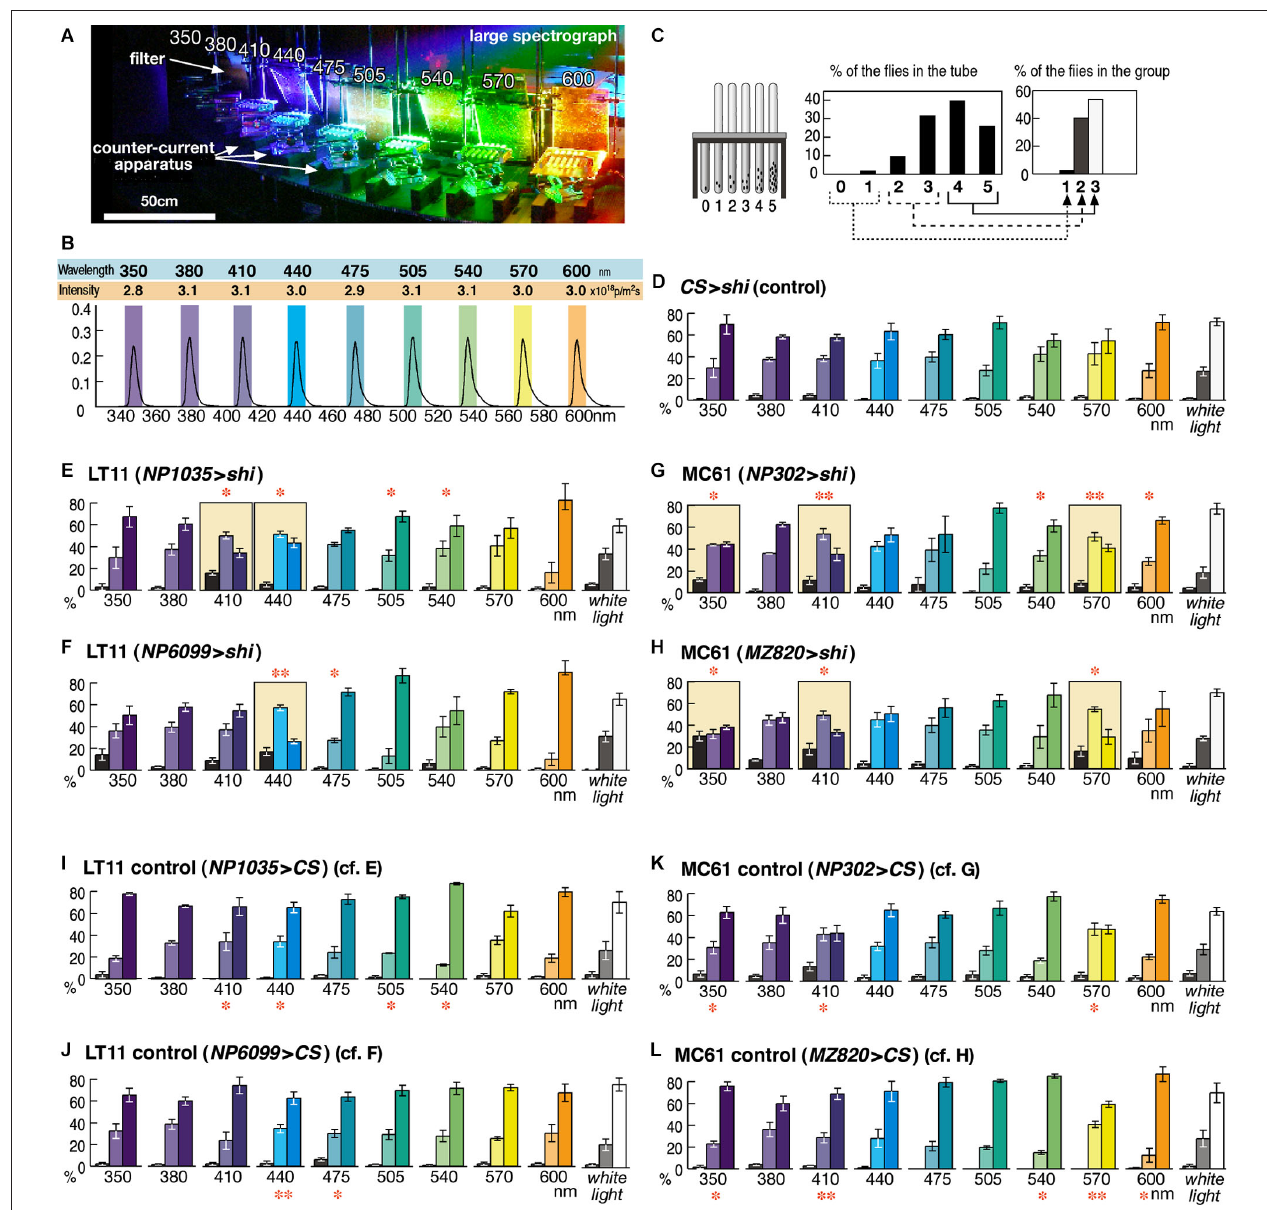
roughly at random (middle, 2), and moved most of the time (right, 3). (D) Control experiment of the wild-type CS flies crossed with UAS- shi ts 1 ( CS > shi ) at 30 ◦ C. Mean ± SEM of three independent measurements. (E–H) Phenotypes of the GAL4 driver strains crossed with UAS- shi ts 1 at 30 ◦ C. Colored background rectangles indicate the cases in which flies showed aberrant phototaxis. The cases that were significantly different from the control (I–L) are indicated with ** ( p < 0.01) and * ( p < 0.05, t -test). (I–L) Control phototaxis experiment of (E–H) ; each GAL4 line was crossed with wild-type CS . Phototaxis at 30 ◦ C was normal in all the cases.